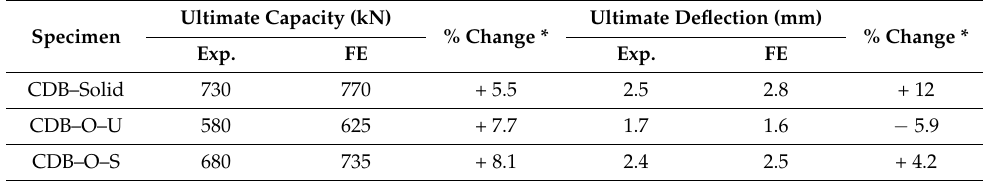
Figure 10. Load mid-span deflection curves for the experimental and FE results. ( a ) Specimen CDB – Solid; ( b ) specimen CDB – O – U; ( c ) specimen CDB – O – S. Table 6. Comparisons between the experimental and FE results. Table 6. Comparisons between the experimental and FE results.